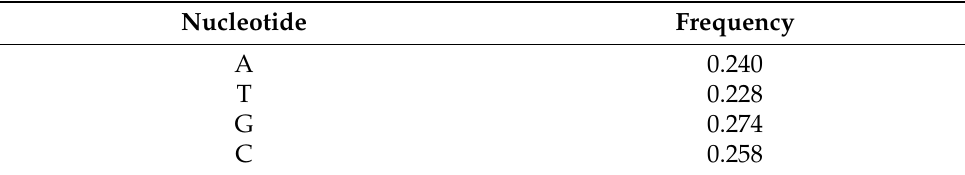
Table 5. Relative nucleotide frequency across slow